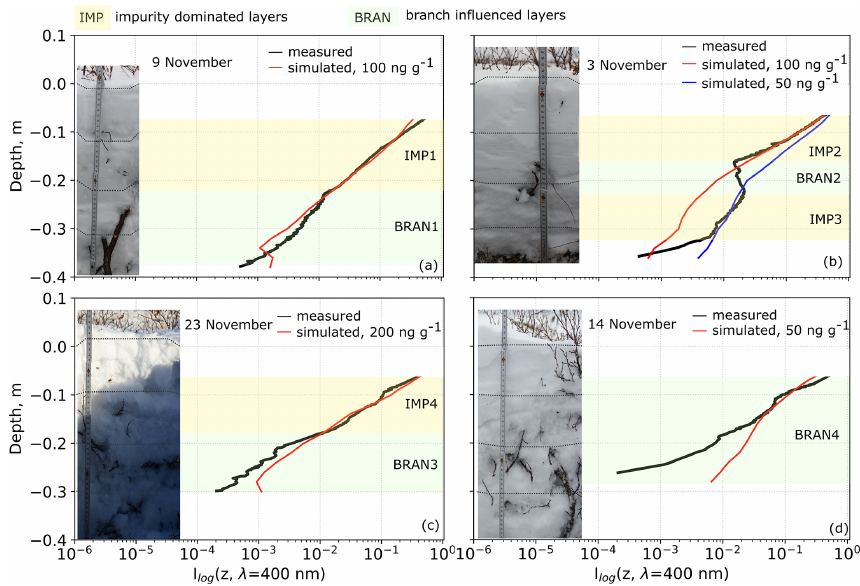
Figure 6. Log-irradiance and SnowMCML simulations at 400nm for measurements taken on (a) 9 November, (b) 3 November, (c) 23 Novem- ber and (d) 14 November in snowpacks with shrubs. Yellow shaded areas highlight layers where measured log-irradiance profiles and SnowMCML simulations fitted well. Green shaded areas highlight layers where log-irradiance and SnowMCML simulations fit less well and branches were visible in the snowpit